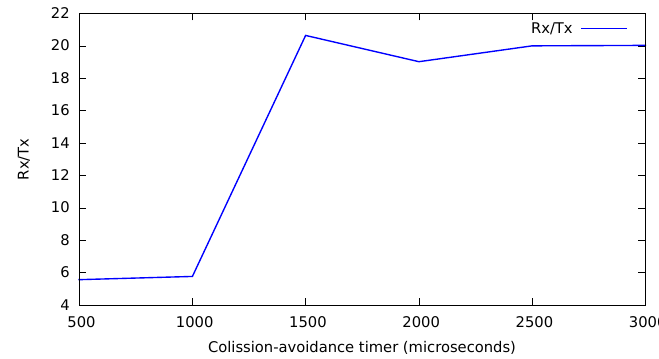
Figure 6. Interest Broadcast Evaluation